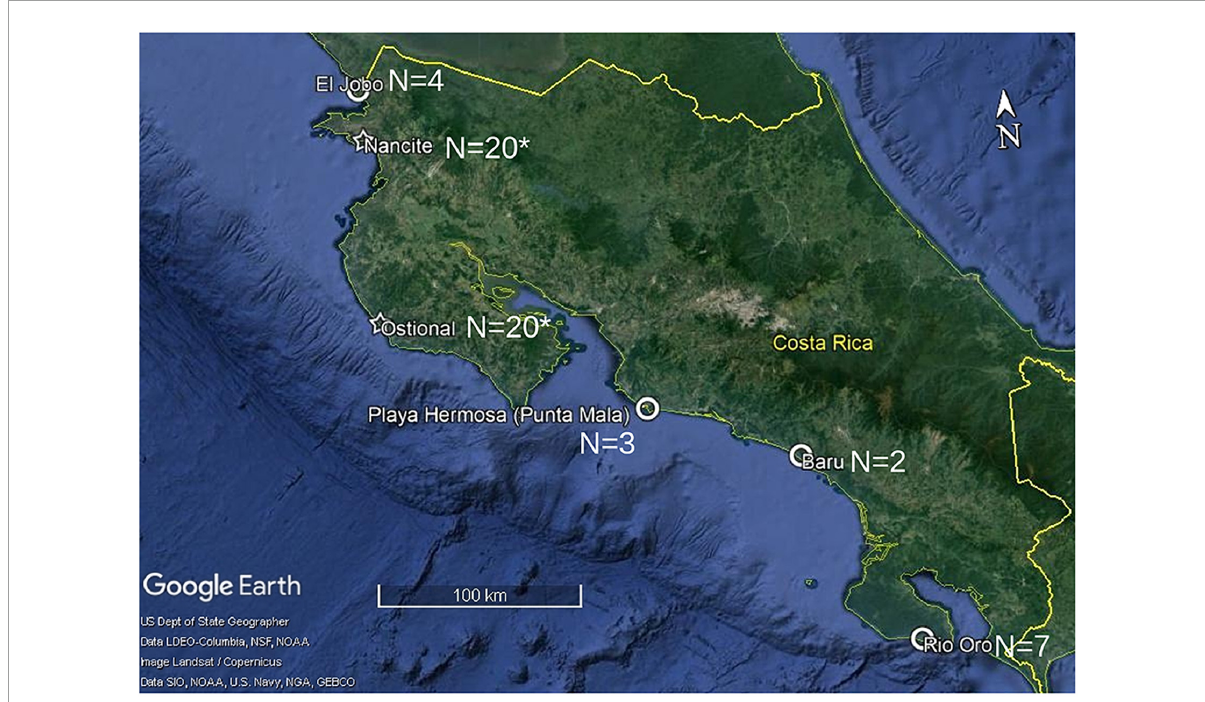
FIGURE1 Map of Costa Rican nesting sites and respective samples sizes where satellite transmitters were attached to olive ridley females about to depart on their post-nesting migrations between 1990 and 1992 (*Plotkin, 2010) and in 2016 and 2017 (this study). Open circles indicate solitary nesting beaches, and stars indicate arribada nesting